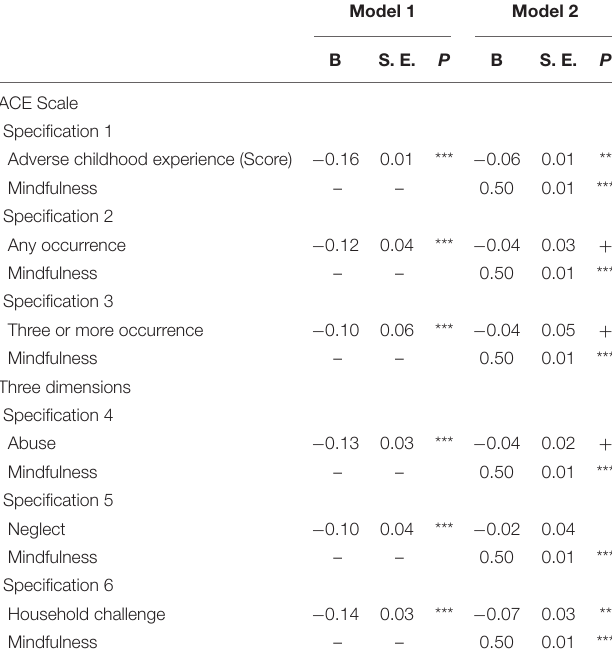
TABLE 5 | Robust tests of grit